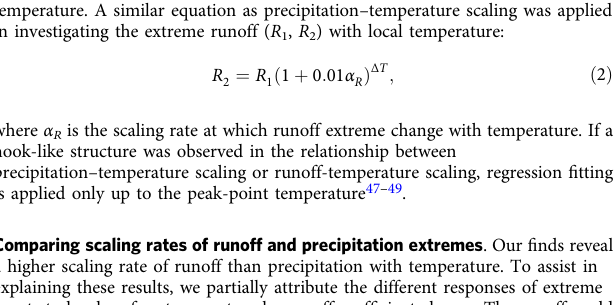
where α P is the scaling rate at which precipitation extreme change with tempera- ture, and could be estimated by a least squared linear method. Binning scaling of runoff extremes with temperature . Before examining the scaling relations between storm runoff extremes and local temperature, we matched the meteorological stations with each runoff station in the same 0.5° ×0.5° grid box, and then the average daily temperature of matched stations was used as local